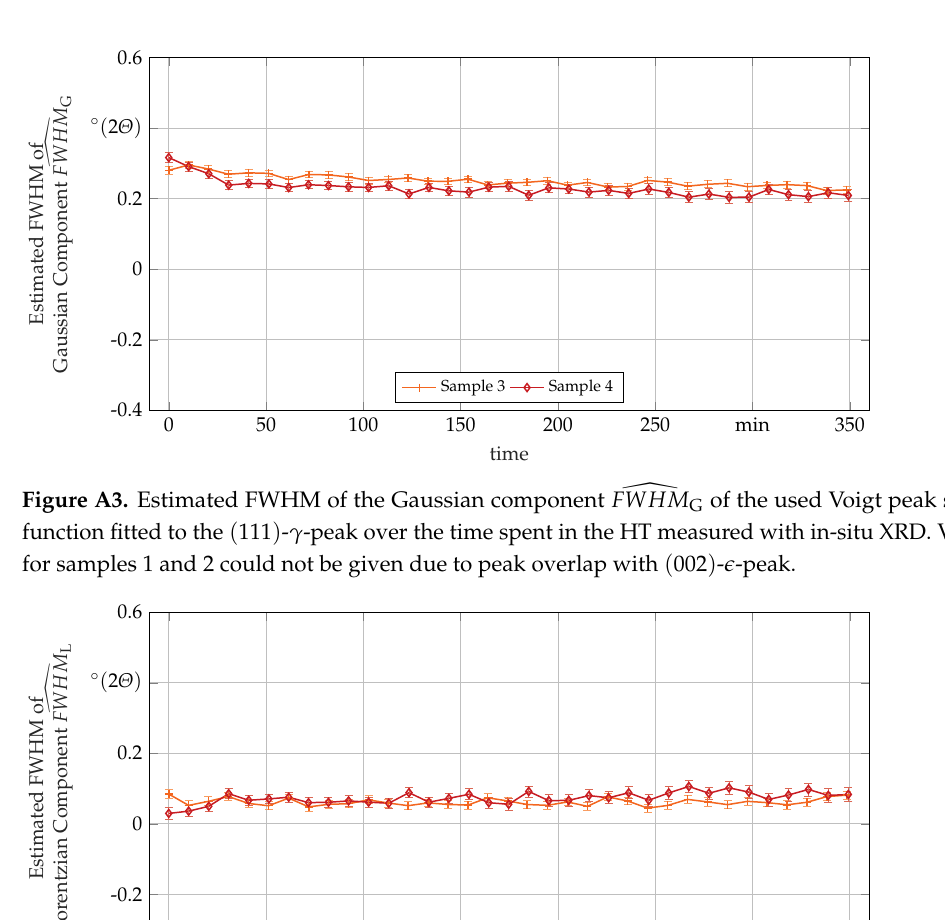
(cid:92) FWHM L of the used Voigt peak shape